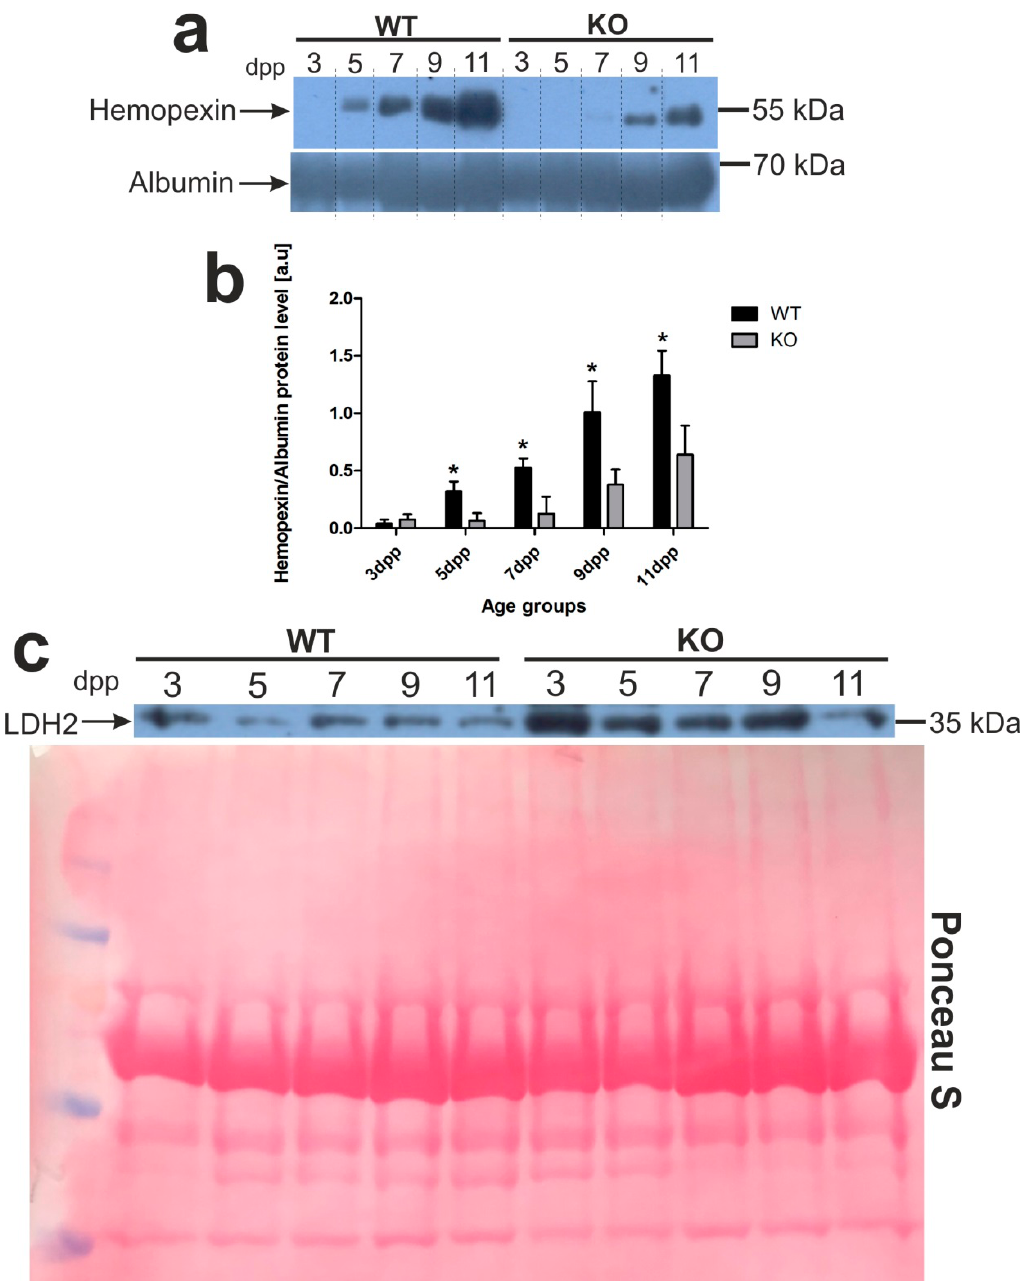
Figure 1. Hemopexin (Hx) and lactate dehydrogenase 2 (LDH2) proteins are markers of intravascular hemolysis in the blood of wild-type and Hmox1 -deficient neonatal mice. ( a ) Plasma levels of hemopexin (Hx) were assessed by Western blotting. The blots were reprobed with polyclonal anti-albumin antibody as a loading control. Results come from three separate blots and relative levels of proteins are shown in the graph ( b ). Immunolabeled Hx and albumin control bands were quantified using a Molecular Imager and the relative levels of the test proteins (means ± SD, n = 3 per group) are plotted in arbitrary units. To compare differences in plasma Hx levels between wild-type (WT) and heme oxygenase 1 (HO1) knockout (KO) groups at each time point, we used Student t -tests for all datasets; * p < 0.05. ( c ) Lactate dehydrogenase 2 (LDH2) plasma levels in the serum from all age groups of wild-type and Hmox1 − / − mice analyzed by Western blotting (WB; representative blot, n = 3). WB PVDF membrane stained with Ponceau S was used as a protein loading control. dpp—days postpartum.